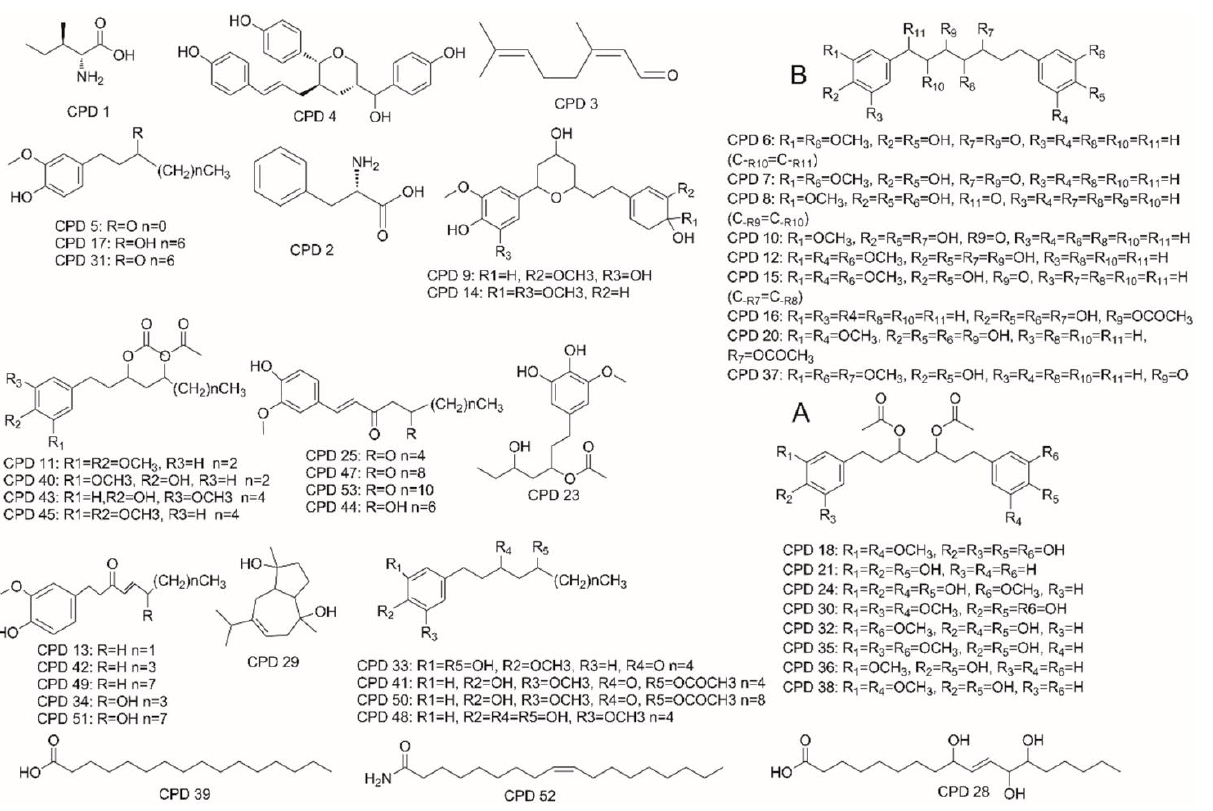
Figure 5. Chemical structure of the compounds identified by UHPLC – ESI – QTOF – MS/MS from dried ginger’s water extract. A, diarylheptanoids with two CH 3 CO atomic groups; B diarylheptanoids with one CH 3 CO atomic group.